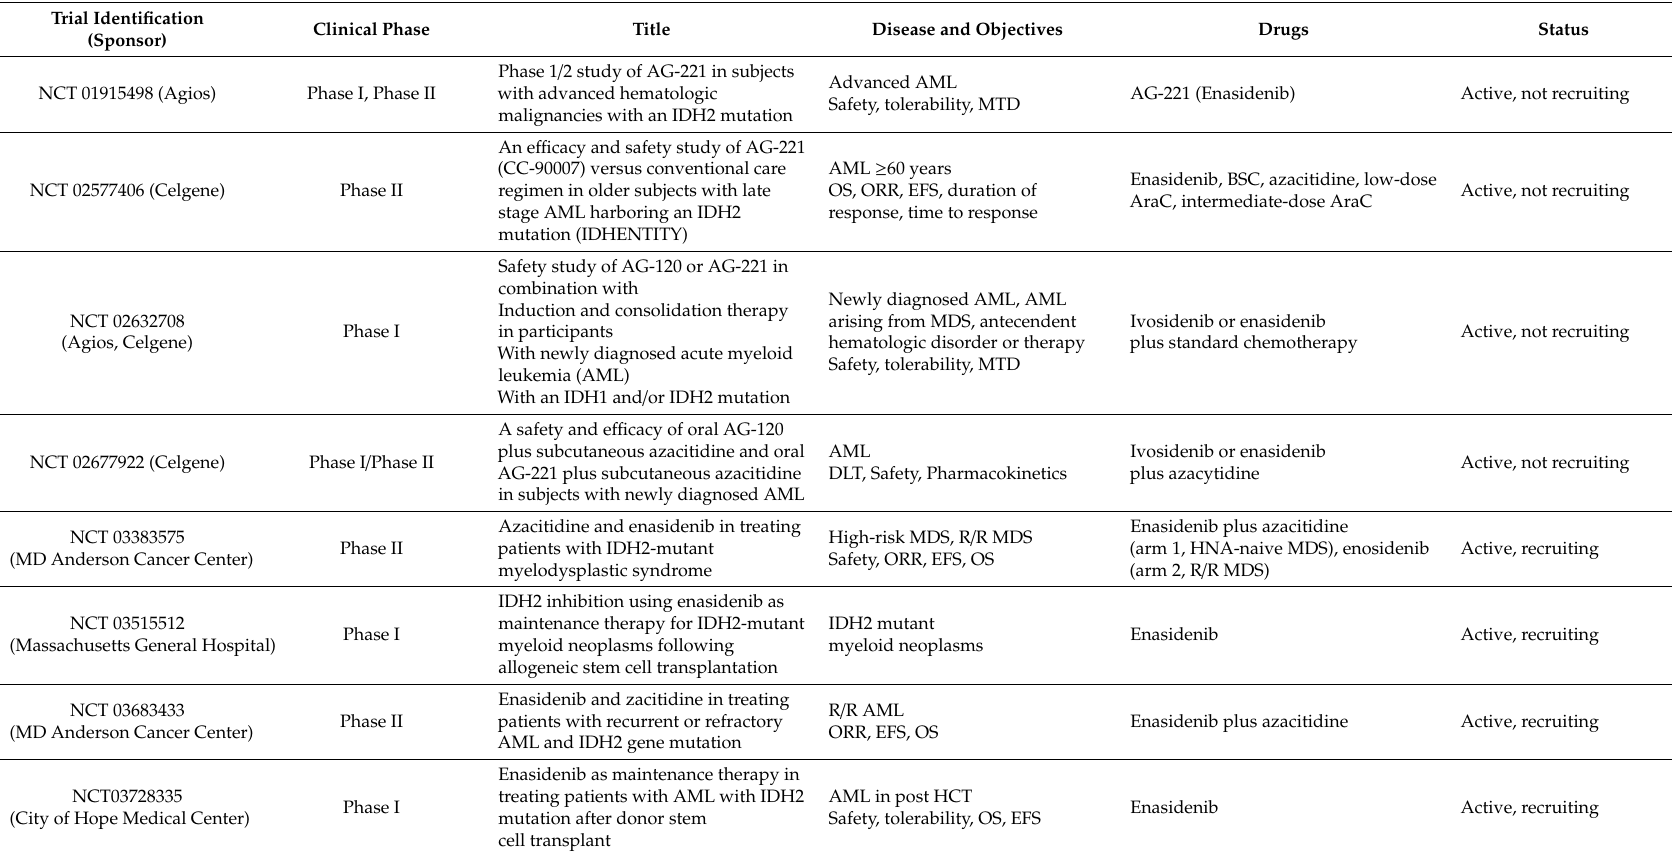
Table 2. Ongoing clinical trials of IDH2 inhibitors in AML and myelodysplastic syndromes